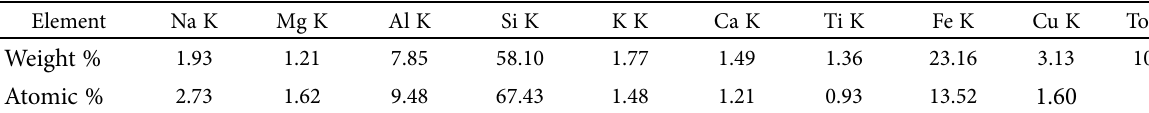
Table 1. Composition of FS Element